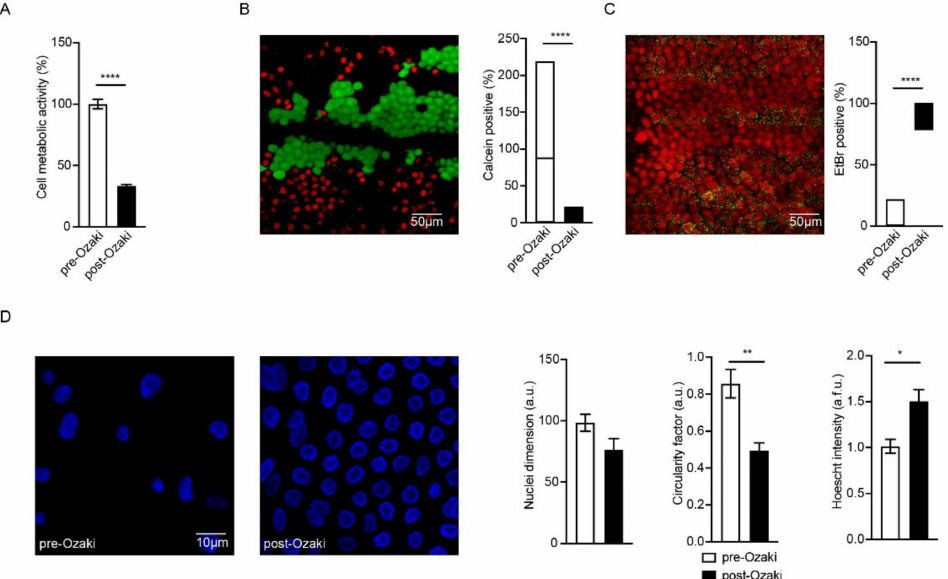
Figure 3. Evaluation of cell viability in peri cardial samples after treatment with GA (post-Ozaki) in comparison to native pericardium (pre-Ozaki). ( A ) MTT assay shows that residual cell viability in post-Ozaki samples is 33.32 ± 1.29% when compared to that of pre-Ozaki samples. **** p < 0.0001; n = 15. ( B , C ) Representative images of pre-Ozaki and post-Ozaki samples, respectively, showing live (green) and dead (red) cells, and their quantification (graphs in panel ( B ) and panel ( C ), respectively). **** p < 0.0001; n = 15. ( D ) Representative images of nuclear morphology following Hoechst staining (blue) and evaluation of nuclei dimension (left graph), circularity factor (center graph), and Hoechst intensity (right graph). * p < 0.05, ** p < 0.01; n =